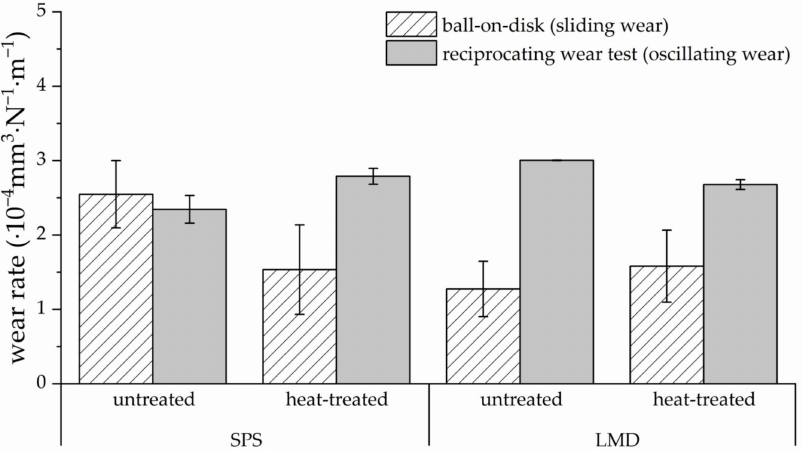
Figure 9. Ball-on-disk (sliding wear conditions) and reciprocating (oscillating wear conditions) wear rates K for the untreated and heat-treated SPS bulk material as well as LMD coating. The untreated SPS bulk material showed a higher resistance to sliding wear. All other conditions showed the